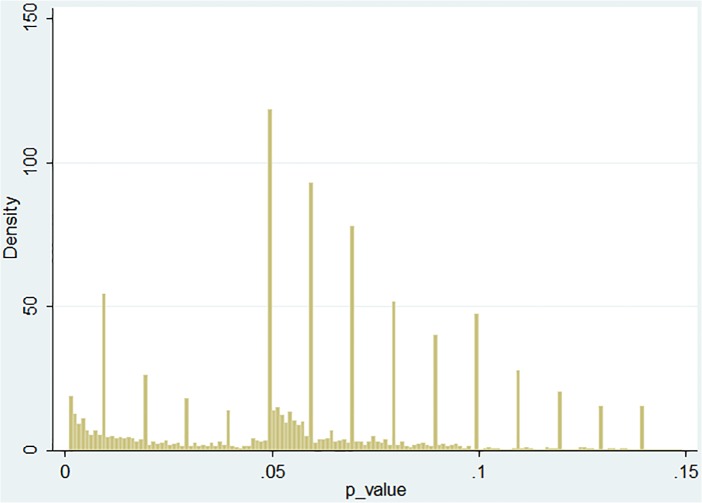
Distribution of directly reported p values (restricted to .001–.15, equal weight of each paper).